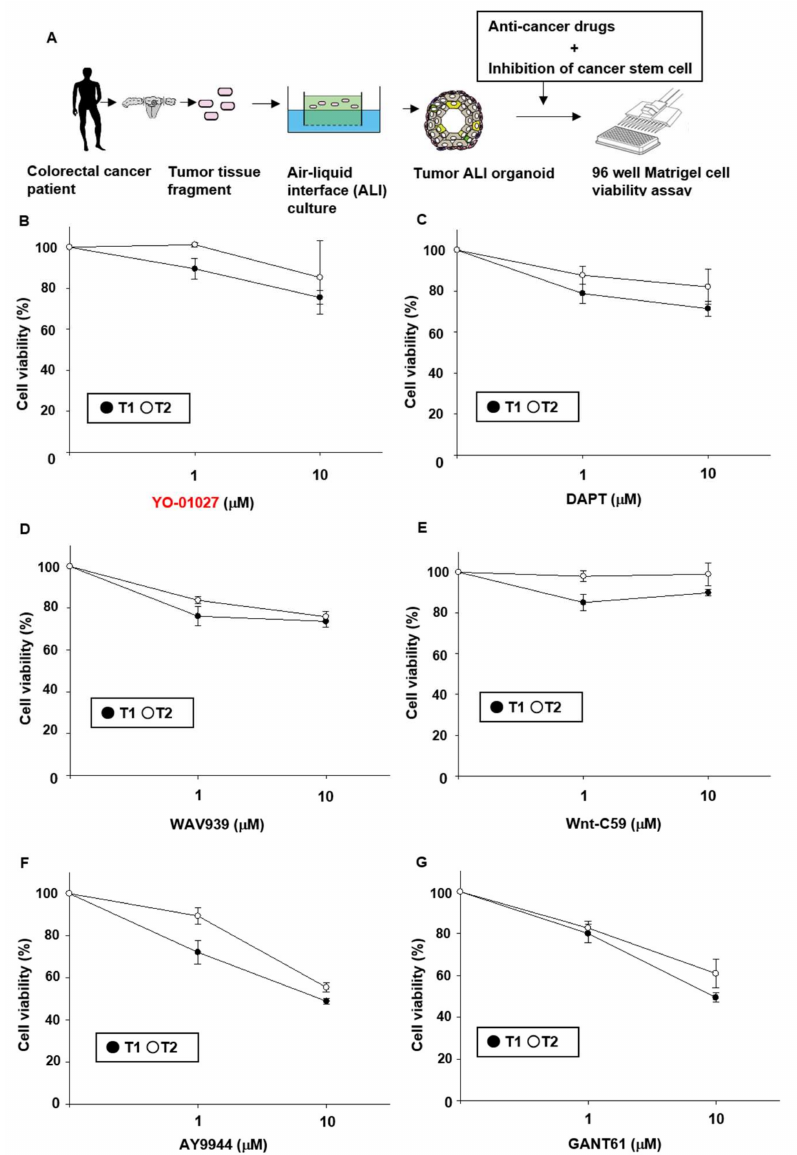
Figure 1. Effects of stem cell-related signal inhibitors on cell viability of tumor air–liquid interface (ALI) organoids. Schematic experimental design of co-treatment with anti-cancer drugs and stem cell-related signal inhibitors in colorectal cancer patient-derived ALI organoids. After tumor organoids were seeded into Matrigel, they were treated with stem cell-related signal inhibitors in the absence or presence of anti-cancer drugs for six days ( A ). Tumor ALI organoids were treated with: Notch signal inhibitors YO-01027 (1–10 µ M) ( B ) and DAPT (1–10 µ M) ( C ); Wnt signal inhibitors, WAV939 (1–10 µ M) ( D ) and Wnt-C59 (1–10 µ M) ( E ); or Hedgehog signal inhibitors, AY9944 (1–10 µ M) ( F ) and GANT61 (1–10 µ M) ( G ) for six days ( n = 6 each for two patients (T1, T2)). Cell viability was determined using an alamablue assay and 100% represents cell viability of each